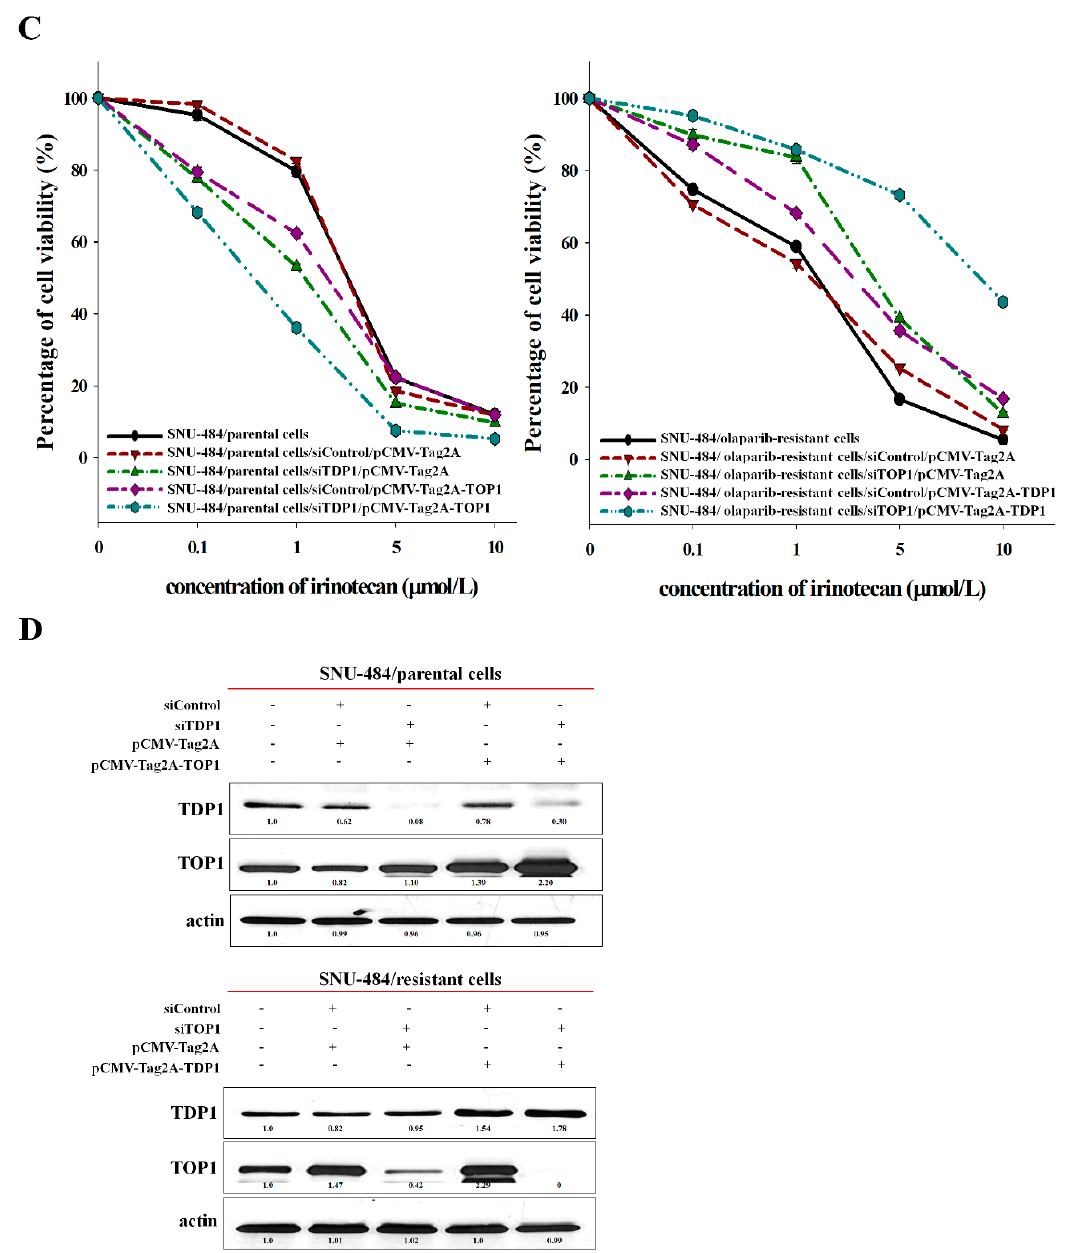
Figure 5. The sensitivities to irinotecan with modulating TOP1 and TDP1 expressions were evaluated by MTT assay. TOP1-siRNA mix, TDP1-siRNA mix, and non-targeting siRNA (160nM each) were transfected into olaparib-resistant cells or parental cells, and then treated with irinotecan for 5 d. Cell viability percentages were then measured by MTT assay, and TOP1 or TDP1 silencing was determined by western blotting ( A and B ). pCMV-tag2A-TOP1 or pCMV-tag2A-TDP1 and/or siTOP1 or siTDP1 were transfected into parental or olaparib-resistant cells. The sensitivity to irinotecan was calculated by MTT assay and the efficacy of transfection was confirmed by western blotting ( C and D ).